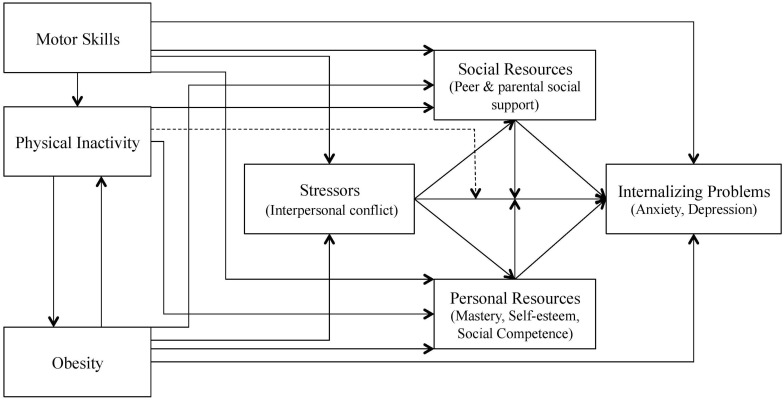
The adapted Environmental Stress Hypothesis by Mancini et al. (2016).